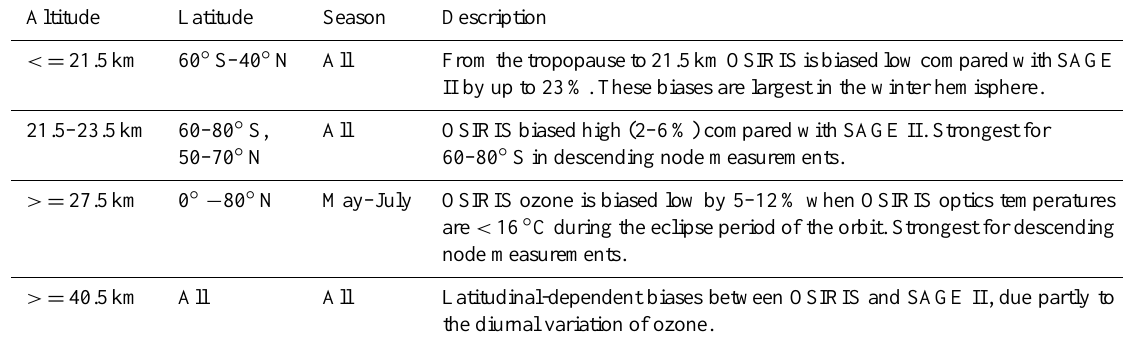
Table 2. Summary of biases between OSIRIS and SAGE II ozone profiles. Altitude Latitude Season Description < = 21.5km All From the tropopause to 21.5km OSIRIS is biased low compared with SAGE II by up to 23%. These biases are largest in the winter hemisphere. All OSIRIS biased high (2–6%) compared with SAGE II. Strongest for 60–80 ◦ S in descending node measurements. > = 27.5km May–July OSIRIS ozone is biased low by 5–12% when OSIRIS optics temperatures are < 16 ◦ C during the eclipse period of the orbit. Strongest for descending node measurements. Latitudinal-dependent biases between OSIRIS and SAGE II, due partly